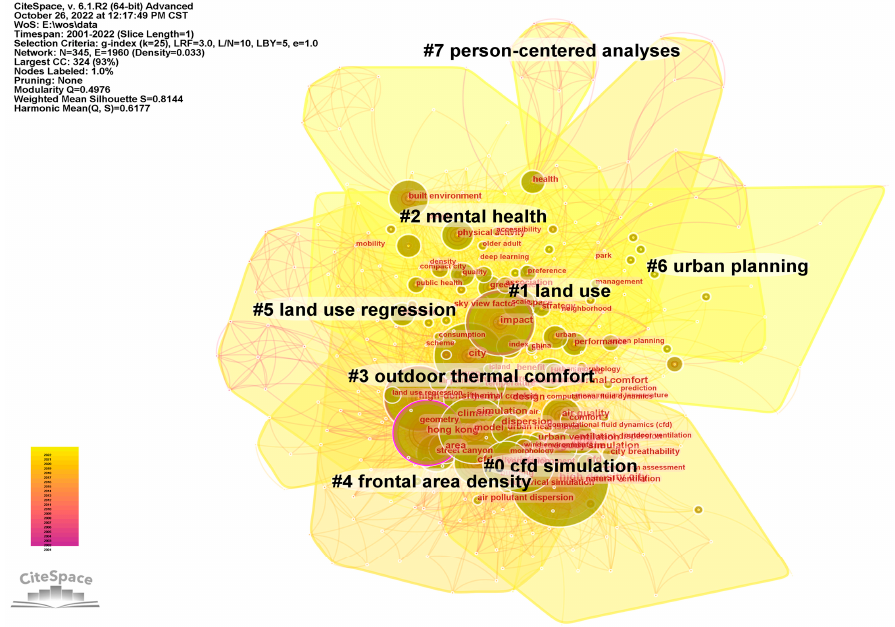
Figure 11. Co-citation network and clusters of papers on high-density cities from 2001 to 2022. Table 10. List of cited clusters and number of contributed records.